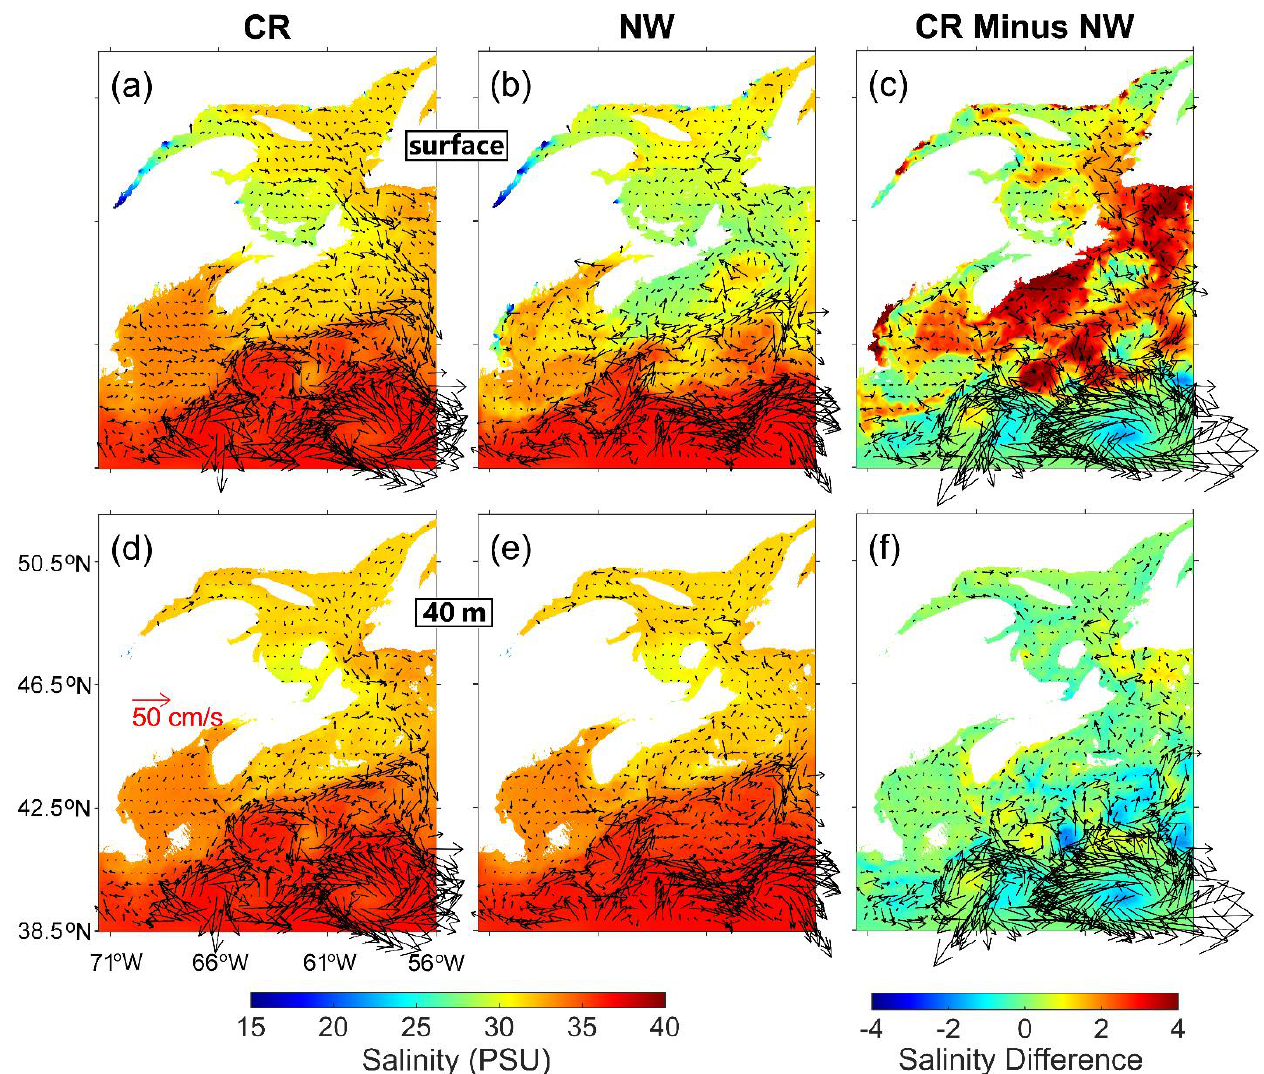
Figure 10. Monthly-mean currents and salinity in February 2018 produced by submodel L2 at ( a , b ) the sea surface and ( d , e ) the 40-m depth over the L2 domain in cases ( a , d ) CR and ( b , e ) NW. Differences in salinity and currents between cases CR and NW at ( c ) sea surface and ( f ) 40 m. For clarity, velocity vectors are plotted at every 14th model grid point. The current velocity vectors are identical to those shown in Figure 8.